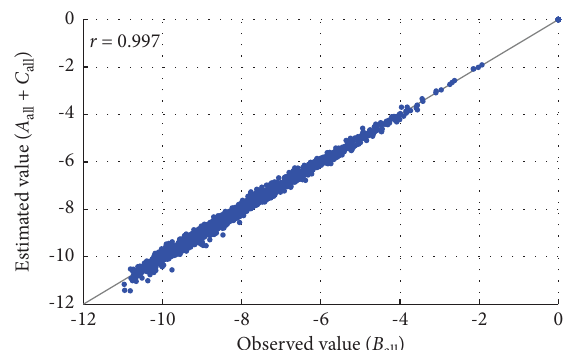
Figure 5: A scatter plot of the observed log-ratios ( B timated ( A